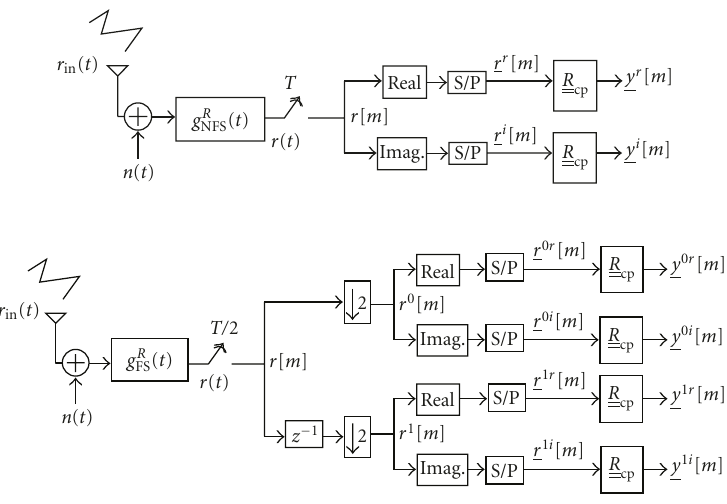
Figure 5: Receiver: upper part NFS, lower part